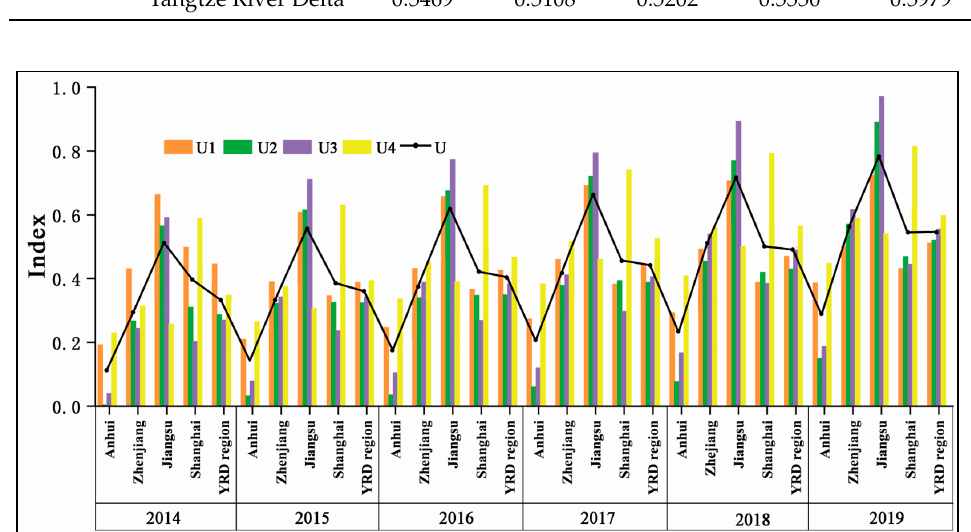
Figure 4. Development index and comprehensive development coefficient of the innovation sub-system.